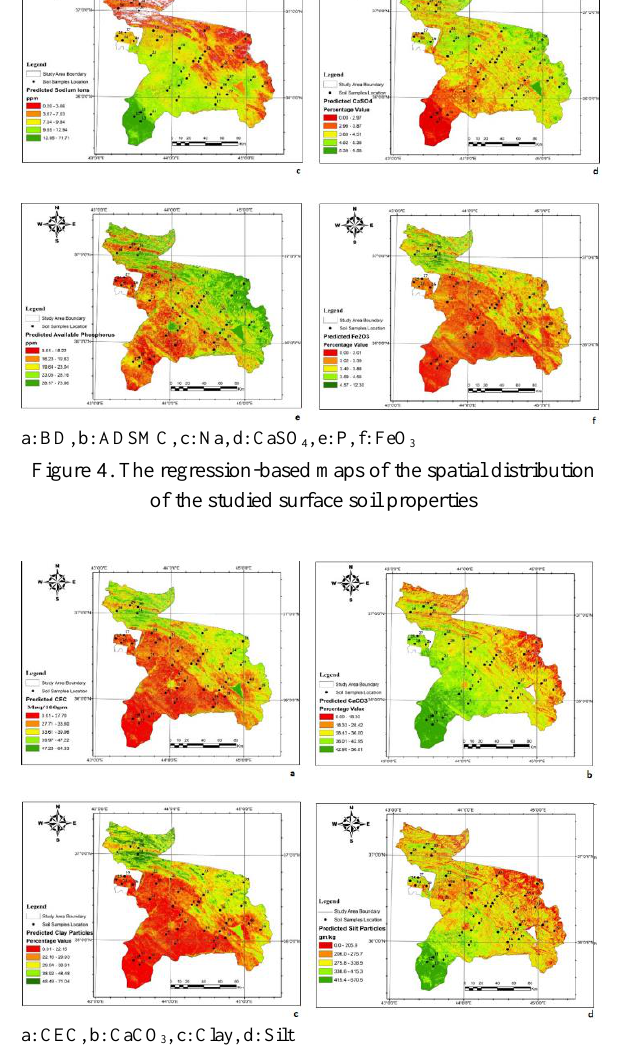
Figure 5. The regression-based maps of the spatial distribution of the studied surface soil